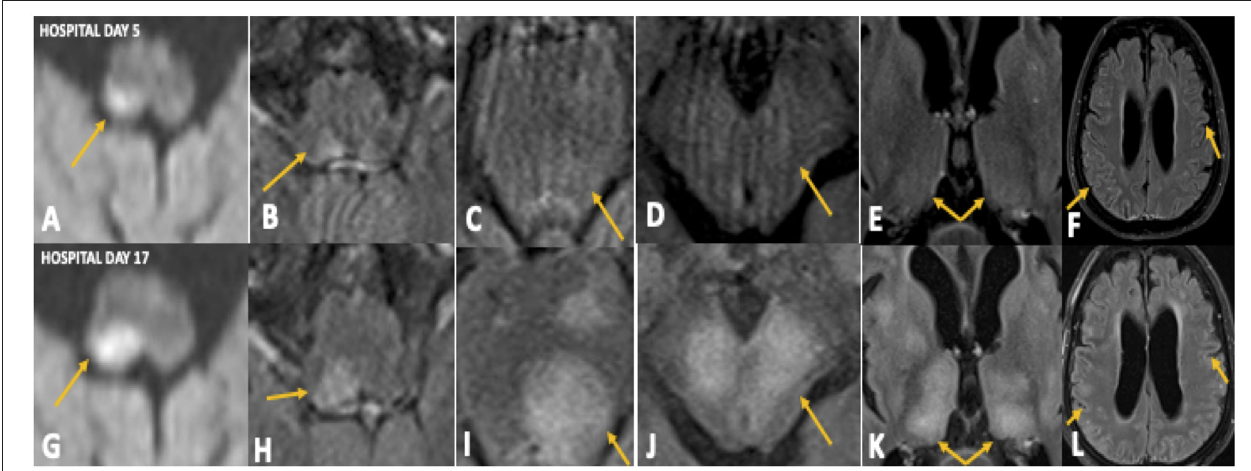
FIGURE 1 | Case 1: Initial MRI brain on hospital day 5 demonstrated diffusion restriction in the right dorsal medulla (A) with corresponding T2 FlAIR hyperintensity (B) , faint T2 hyperintensities in the left pons (C) , midbrain (D) , and thalamus (E) , and minimal T2 sulcal hyperintensity without contrast enhancement (F) . Repeat MRI brain on hospital day 17 showing significant progression of these abnormalities (G–L)